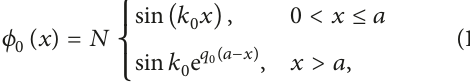
Figure 2: Probability distribution 𝜌 𝑡 (𝜏) for the tunneling times 𝜏 , obtained by Monte Carlo samplings of 𝑘 -values from the distribu- tion 𝜌(𝑘) and then transforming these to time values through 𝜏 = 𝑡 𝑇 (𝑘) . The parameters are the same as in the corresponding plots in 𝑐 Figure 1 and are all expressed in Rydberg atomic units. Top: 2𝐿 = 2 . Bottom: 2𝐿 = 16 . These plots are in the same range and scale and can be compared. The vertical grey line in both plots corresponds to the time the light takes to traverse the barrier distance. The ticks in the horizontal axes correspond to the light time, the minimum, the median and the maximum values of 𝜏 in the histogram (in the bottom plot the maximum 𝜏 is out of the plot’s